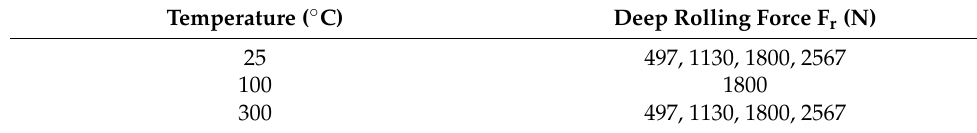
Figure 4. Components of the heating device.